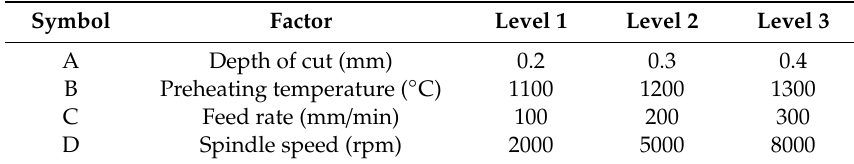
Table 4. The factors and levels used in the experiments.